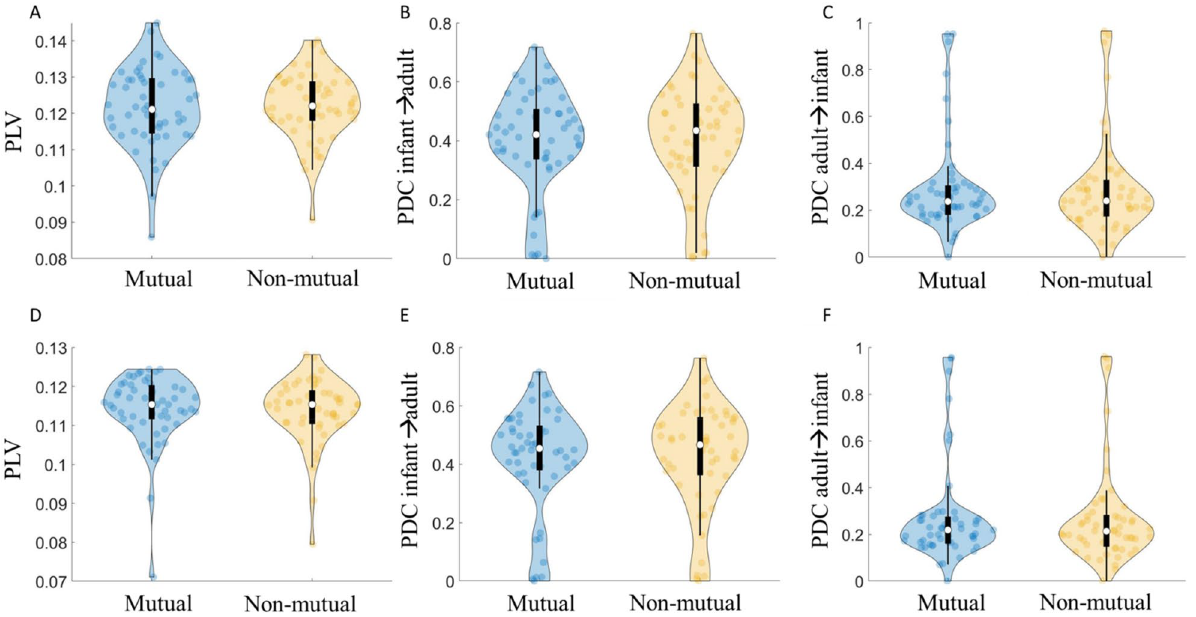
Figure 4. Results of non-event locked inter-brain synchrony analysis. ( A ) Infant-adult PLV during mutual/ non-mutual gaze in Theta. ( B ) Infant → adult PDC during mutual/non-mutual gaze in Theta. ( C ) Adult → infant PDC during mutual/non-mutual gaze in Theta. ( D ) Infant-adult PLV during mutual/non-mutual gaze in Alpha. ( E ) Infant-adult PLV during mutual/non-mutual gaze in Alpha. ( F ) Adult → infant PDC during mutual / non-mutual gaze in Alpha. Violin plots show the distribution of the data with an inset boxplot. Each point corresponds to the average PLV/PDC value of a